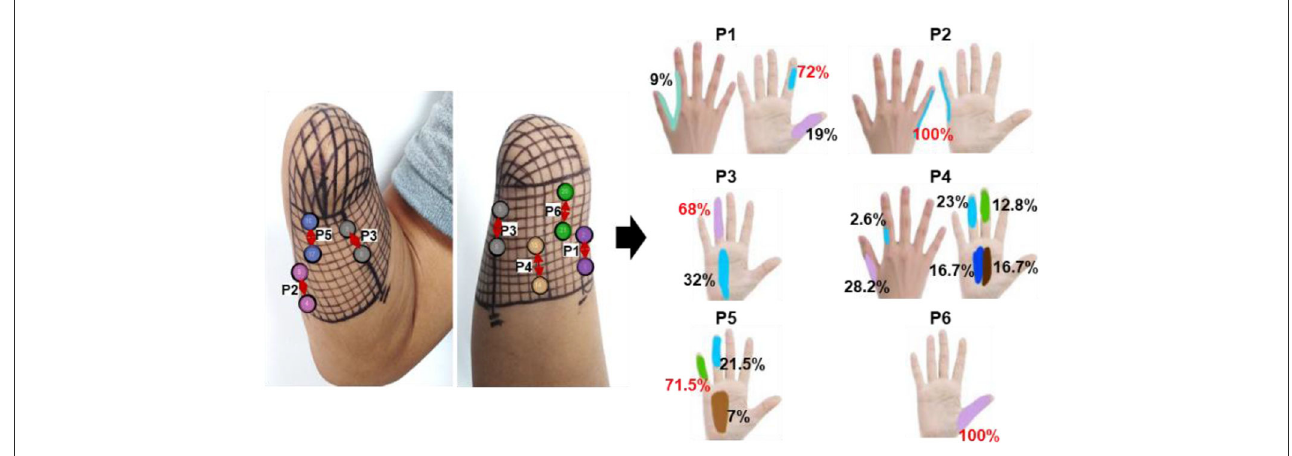
FIGURE6 The positions of evoked sensations when the six selected positions were stimulated by TENS under the SS